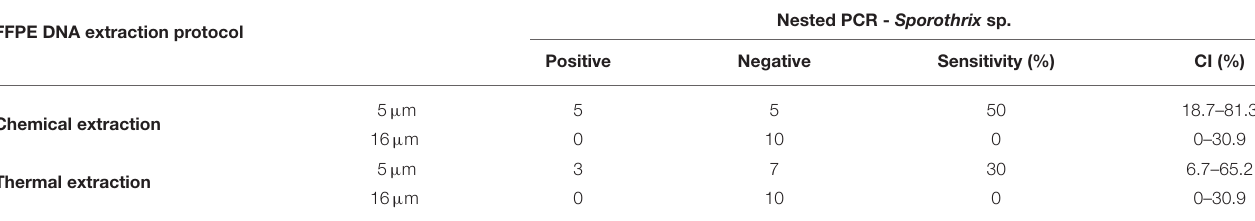
TABLE 2C | Comparison of chemical and thermal DNA extraction protocols in clinical FFPE skin samples from ten cats, using the two paraffin sectioning protocols (5 and 16 µ m), in relation to the positivity, method sensitivity and confidence interval (95% CI). FFPE DNA extraction